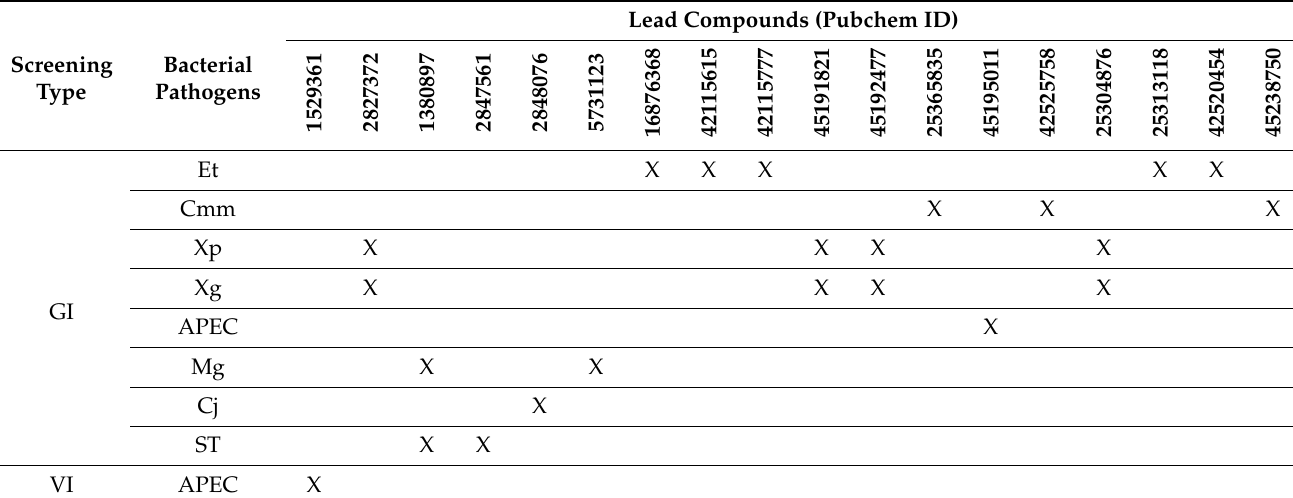
Table 3. Lead compounds identified across different bacterial pathogens.